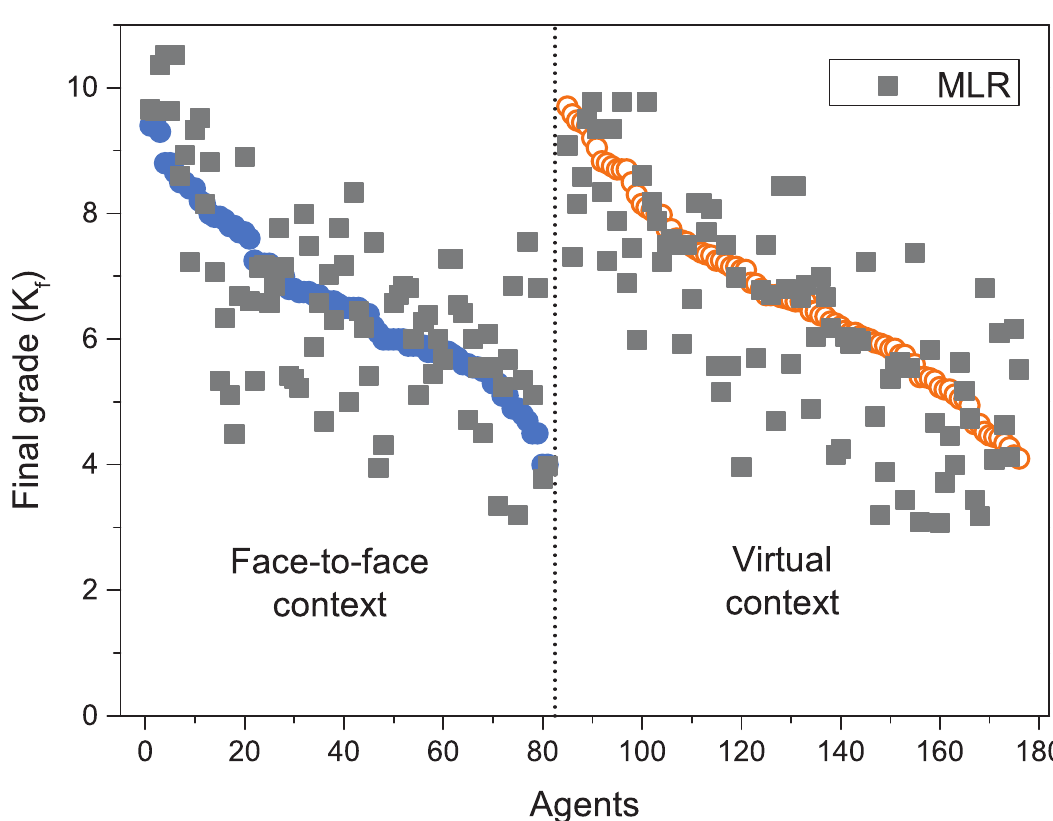
Fig 7. Final knowledge comparison between the actual final grade obtained for each student in both contexts (circles) and the KA Model of Eq 1 using the coefficients obtained with the MLR approach (squares).